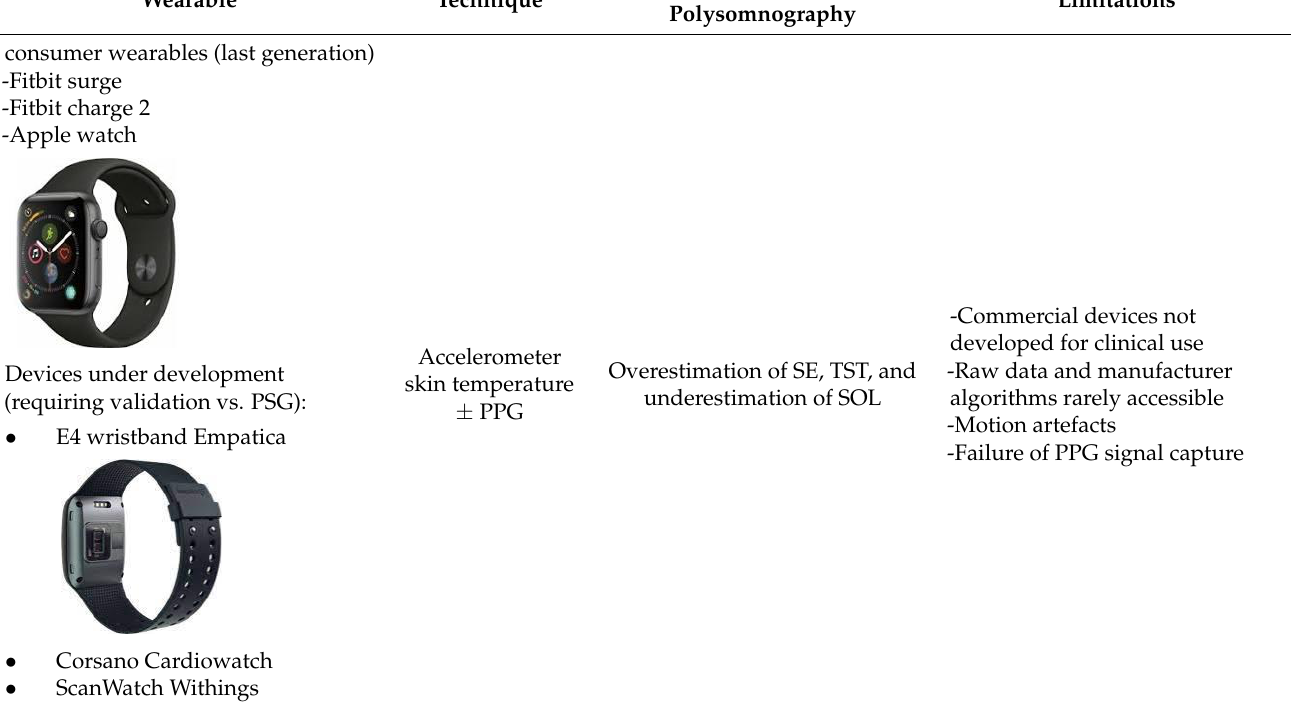
Table 2. Cont. Overall Performance